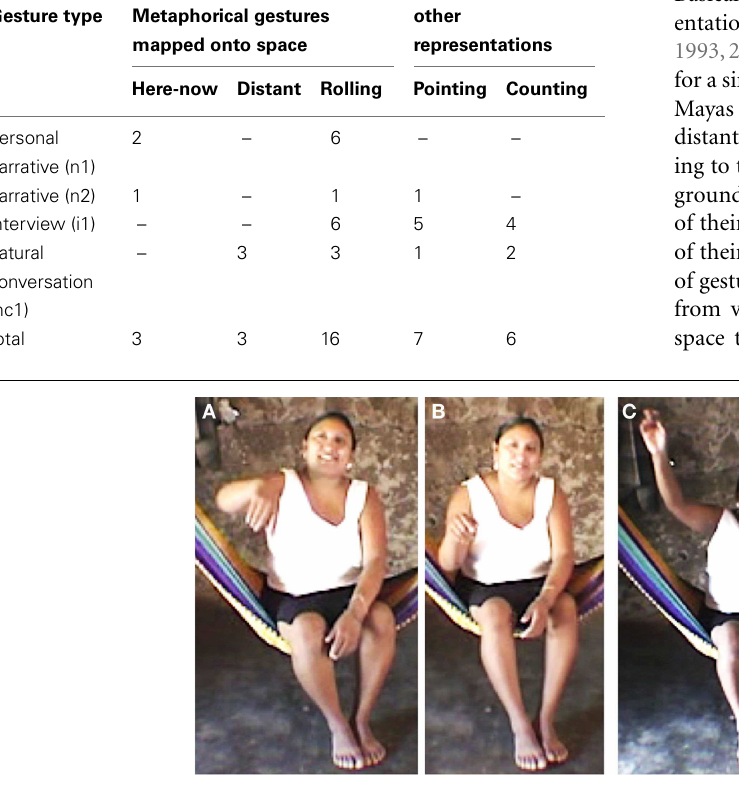
FIGURE 4 | Elicited gestures for (A) waye’ “here,” (B) be’òora “now,” (C) binih “he went (away, unknown where),” (D) úuchk’iin “long time (past or